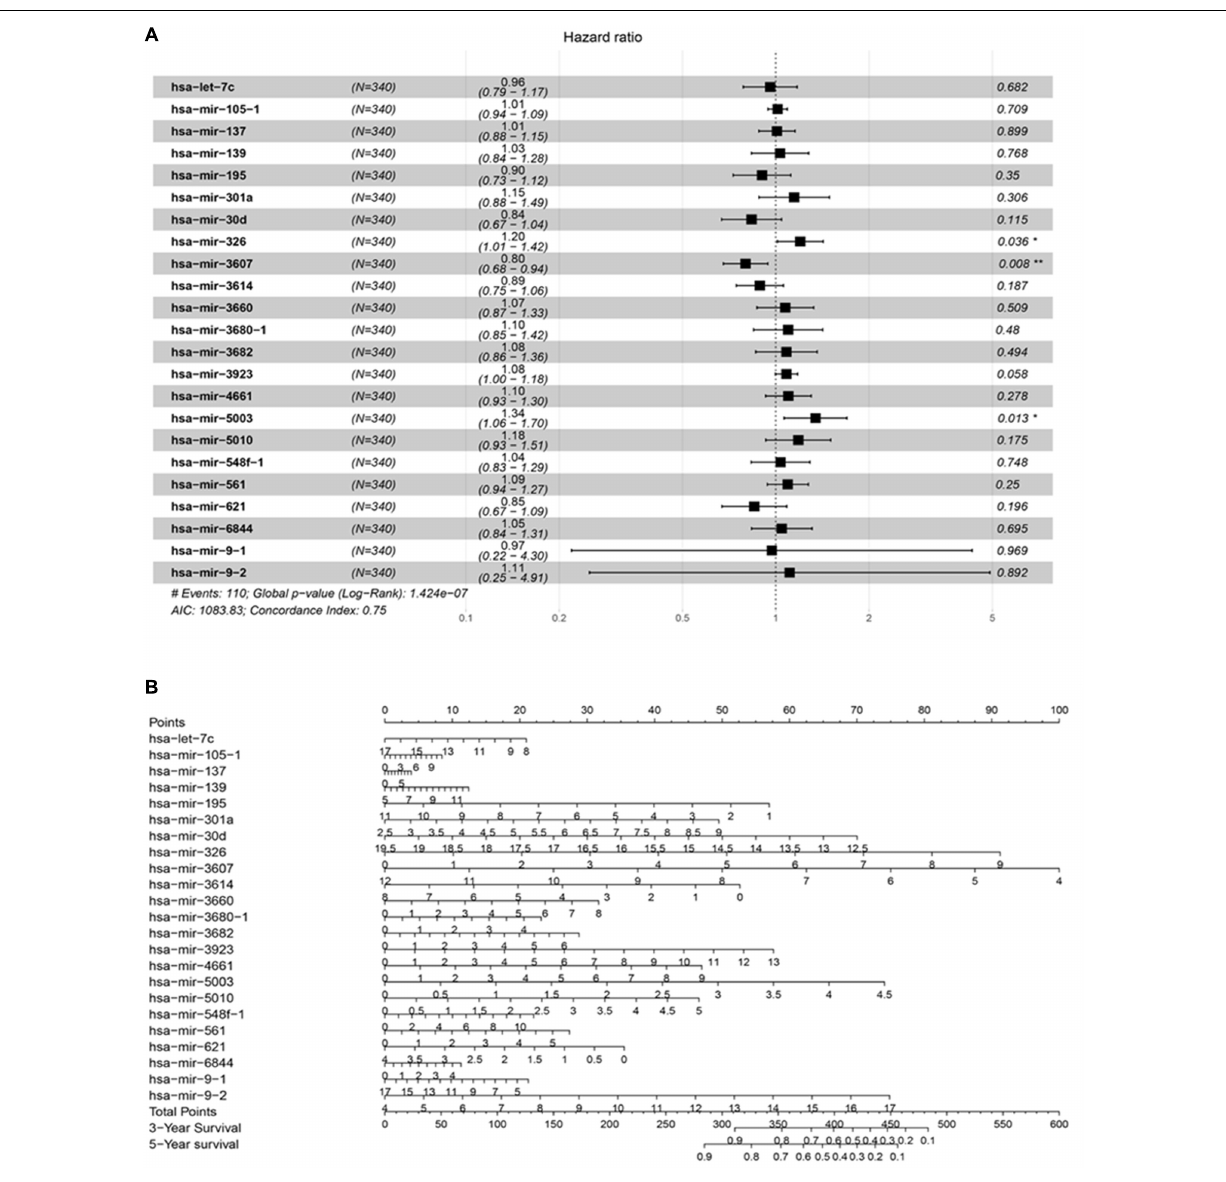
FIGURE 3 | The prognostic predictive model for HCC. (A) The analyzed result of multivariate Cox proportional hazards regression involved with recurrence in TCGA HCC cohort. The middle point of the line indicates the hazard ratio (HR), and the whole length on behalf of the 95% CI for each DEmiRNA. (B) Nomogram based on differentially expressed miRNAs to predict survival in HCC asymptomatic individuals. The prognostic model aim to estimate the survival rate for individual patient, meanwhile reveal the upregulated or downregulated type for each miRNA. At first, draw a line straight upwards from each miRNA to obtain the points from the points axis. Repeat this step until the total scores were gained for 23 miRNAs. Then, after calculating the overall points according to the total points axis, draw a line straight down to the 3-year and 5-year survival axis from the location of total point axis based on the obtained overall scores to indicate the rate for the specific patient (for e.g., the 3-year survival rate is 60% if a patient get the total points of